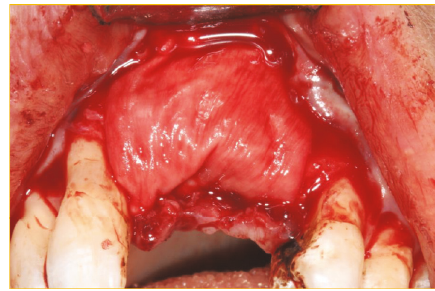
Figure 12: Bio-Gide has been folded over the Bio-Oss granules.